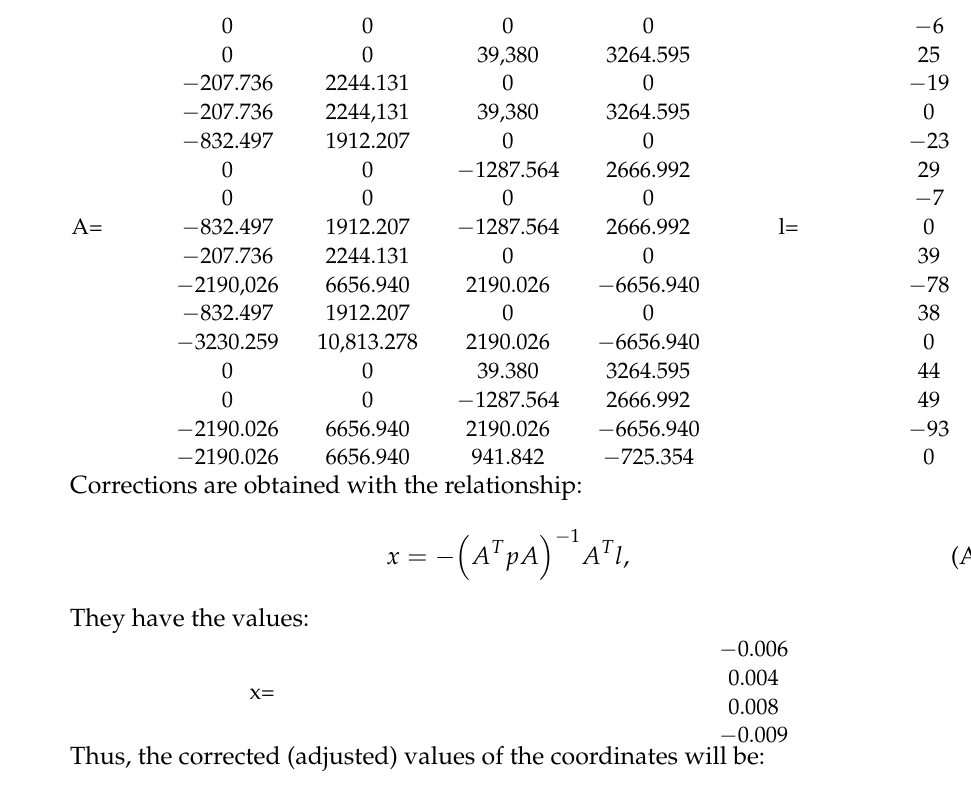
Table A4. Adjusted coordinates of S3 and S4.